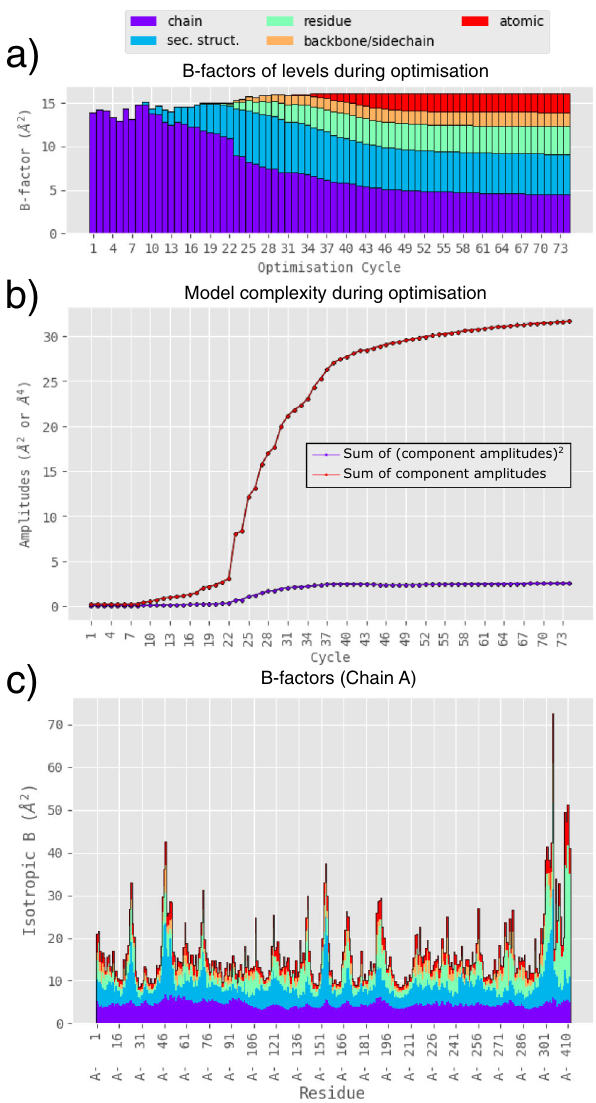
Fig. 3 Optimisation and ECHT disorder pro fi le of a structure of the SARS- CoV-2 main protease (7k3t). a The average B-factor of each level for each optimisation cycle. Optimisation begins with large weights on the number of model parameters, forcing disorder to be modelled only using large-scale groups, i.e., at the chain level. As optimisation cycles increase, the penalty on the number of model parameters decreases and disorder is increasingly allowed at smaller and smaller scales, improving model fi t until the model converges. b The sum of the (squared) amplitudes for each independent model component (e.g., TLS group), representing model complexity, for each optimisation cycle. These values are used to penalise model complexity during elastic-net optimisation. Amplitudes can be converted to the units of B-factors by multiplying by 8 π 2 . c The fi nal ECHT disorder pro fi le after optimisation, shown as the magnitude of the atomic B-factors averaged over each residue and coloured by